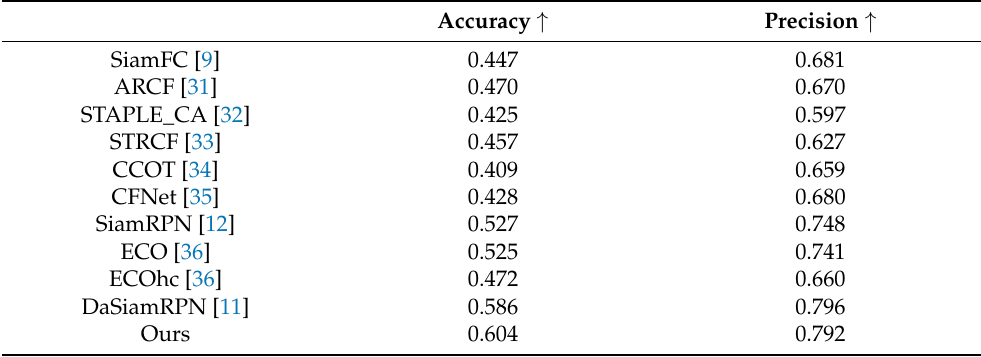
Table 1. Results on UAV123 benchmark. Red fonts indicate the top tracker. ↑ indicates that the larger the parameter value, the better the tracker